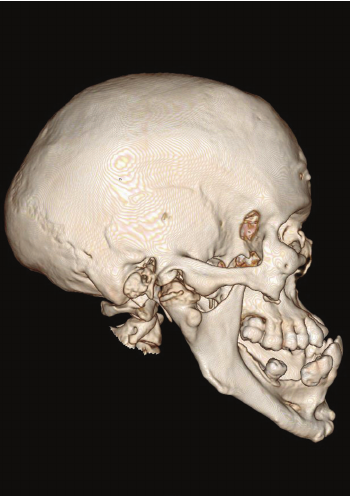
Figure 9: Lateral view of 3D volume rendered CT scan showing enlarged right condyle, coronoid process, mandibular body, and